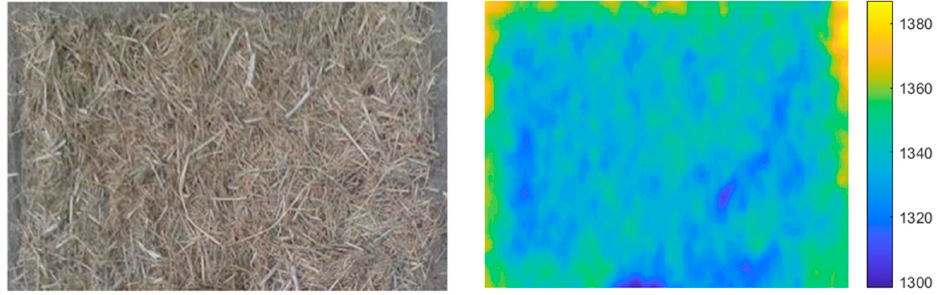
Figure 3. Straw coverage image and depth image.